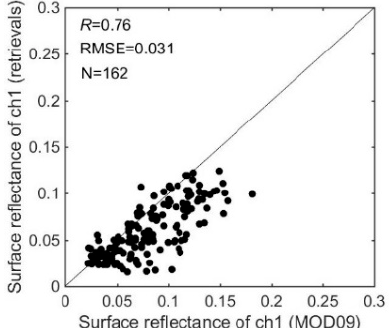
Figure 13. Comparison of the retrieved AVHRR channel 1 (0.63 μ m) surface reflectance and MOD09GA channel 1 (0.66 µ m) surface reflectance result. The line is the 1:1 plot. The text denotes the R , the RMSE error and the number of retrievals (N).